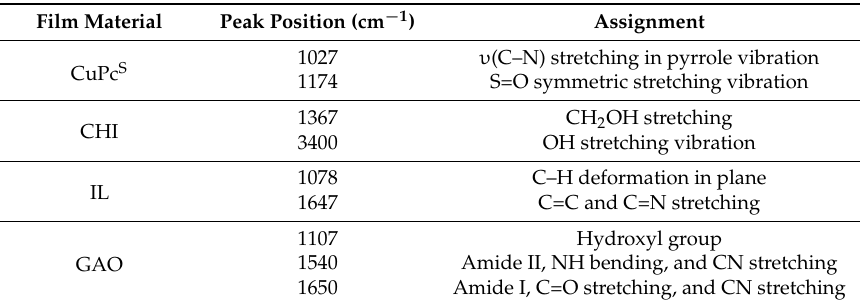
Figure 3. FTIR spectra of LbL for ( a ) [CHI+IL/CuPc S ] 8 films and ( b ) [CHI+IL/CuPc S ] 8 -GAO films. Table 1. Assignments for the FTIR spectra of LbL films in Figure 3.